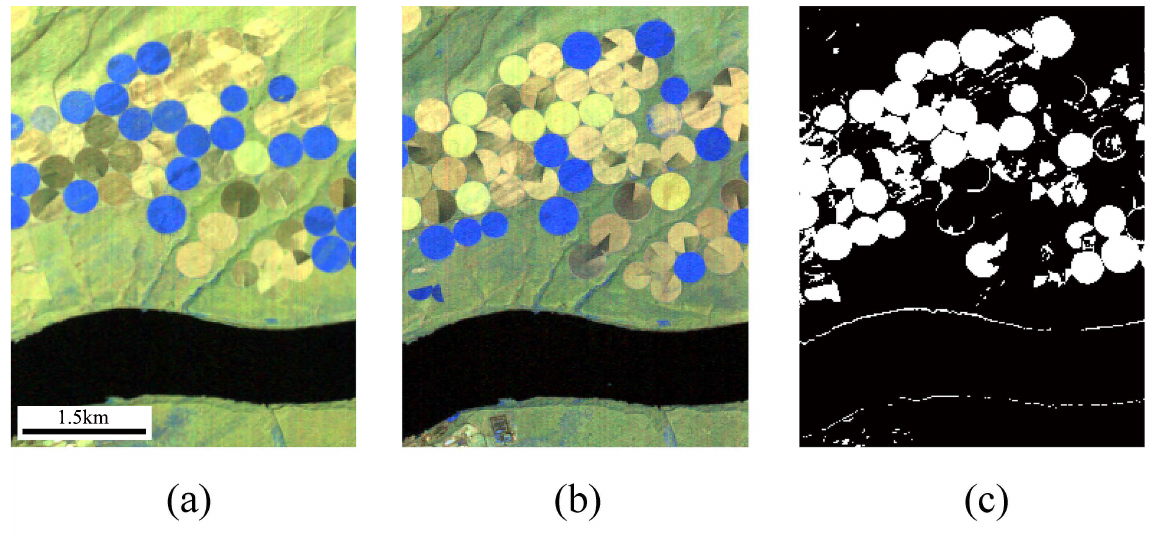
Figure 6. Irrigated Agriculture Dataset with false color map (Bands 134, 90m and 75 as RGB). ( a ) U.S. farmland image captured on 1 May 2004. ( b ) U.S. farmland image captured on 8 May 2007. ( c ) Binary ground truth for the Irrigated Agriculture Dataset.